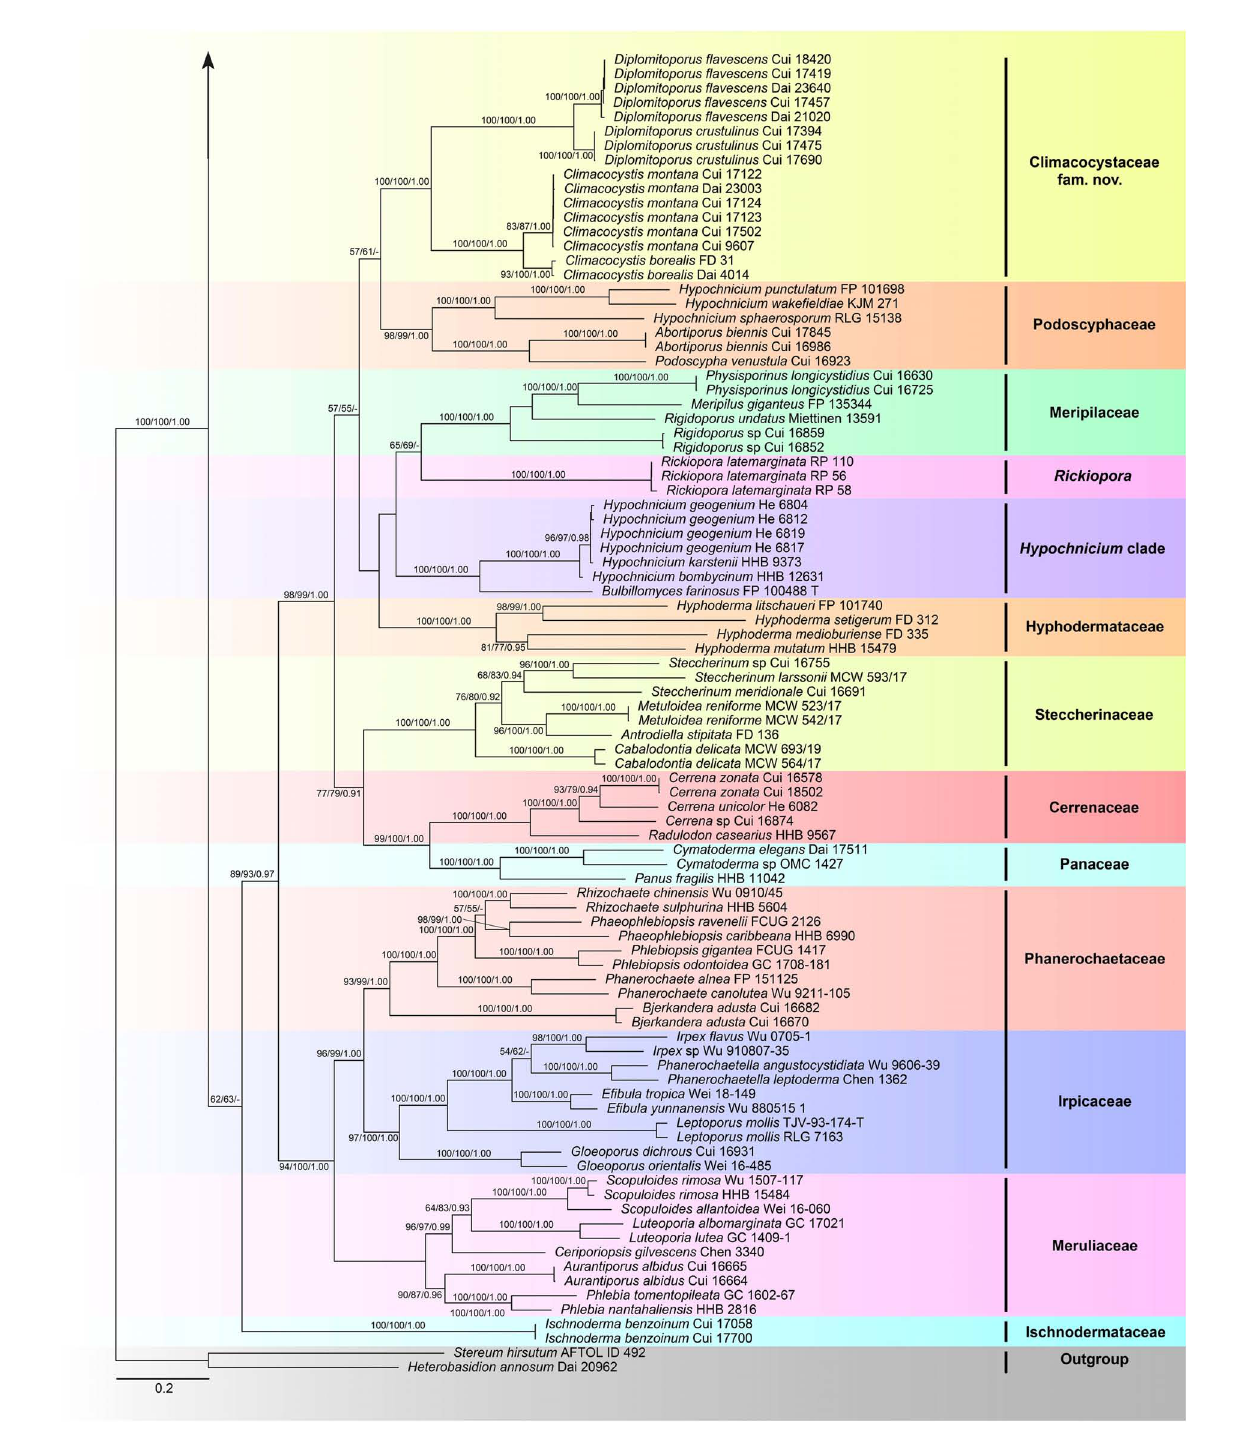
FIGURE2 Maximum likelihood tree illustrating the phylogeny of the Polyporales based on the combined sequence dataset of ITS + nLSU + RPB1 + RPB2 + TEF1. Branches are labeled with parsimony bootstrap proportions higher than 50%, maximum likelihood bootstrap higher than 50%, and Bayesian posterior probabilities more than 0.90,